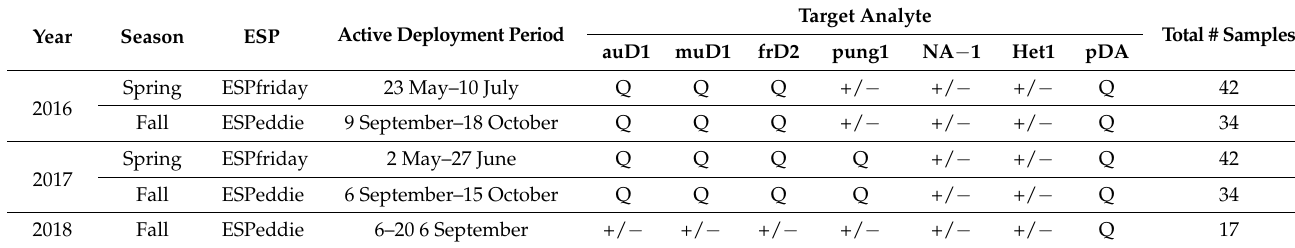
Table 3. Dates when ESP was actively sampling (i.e., active deployment period), target analytes, and the total number of samples analyzed for each deployment on the Washington shelf. “Q” indicates that the target analyte was quantitatively determined and “+/ − ” indicates that it was monitored for presence/absence only. Target analytes are Pseudo-nitzschia australis (auD1), P. multiseries (muD1), P. fraudulenta (frD2), P. pungens (pung1), Alexandrium catenella (NA1), Heterosigma akashiwo (Het1), and particulate domoic acid (pDA).